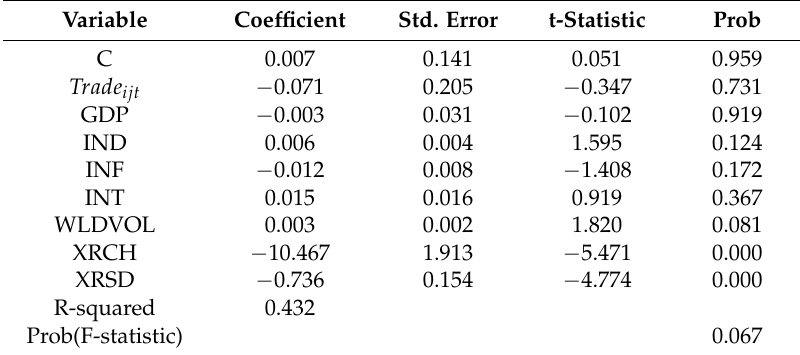
Table 9. Determinant of Stock Market Co-movement between Pakistan and Malaysia.